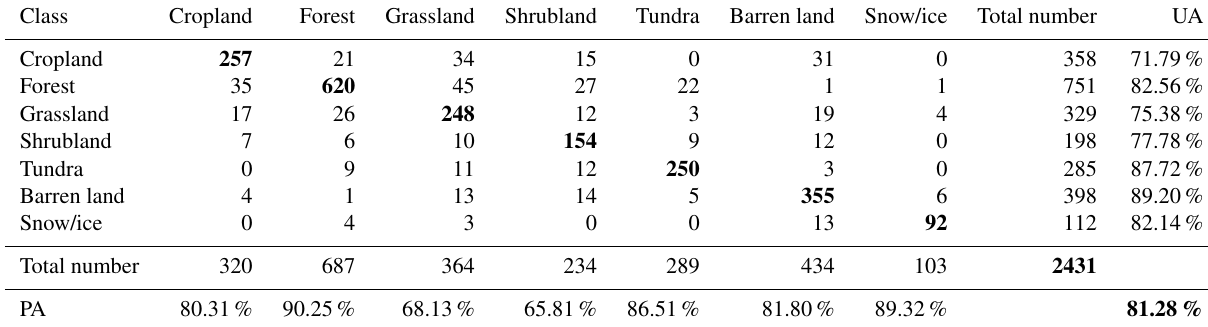
Table 5. Classification accuracy of GLASS-GLC (annual dynamics of global land cover) without change detection under independent test samples (overall accuracy = 81.28%; UA denotes user’s accuracy, and PA denotes producer’s accuracy). Bold numbers represent correctly classified ones.